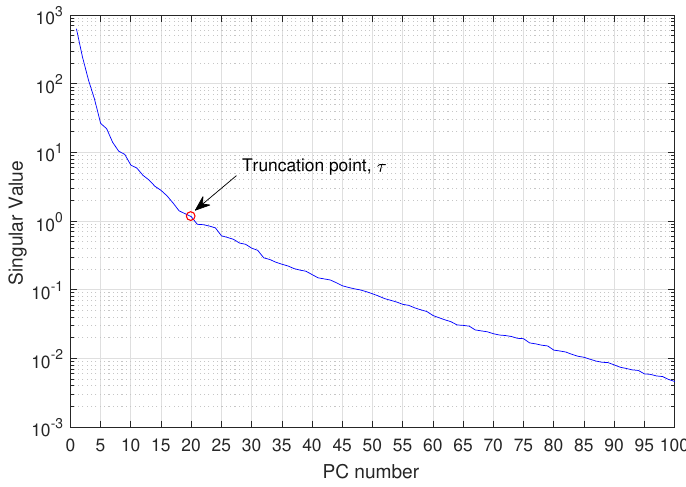
Figure 8. Singular values of the PCA decomposition of the ensemble of spectra shown in Figure 6.